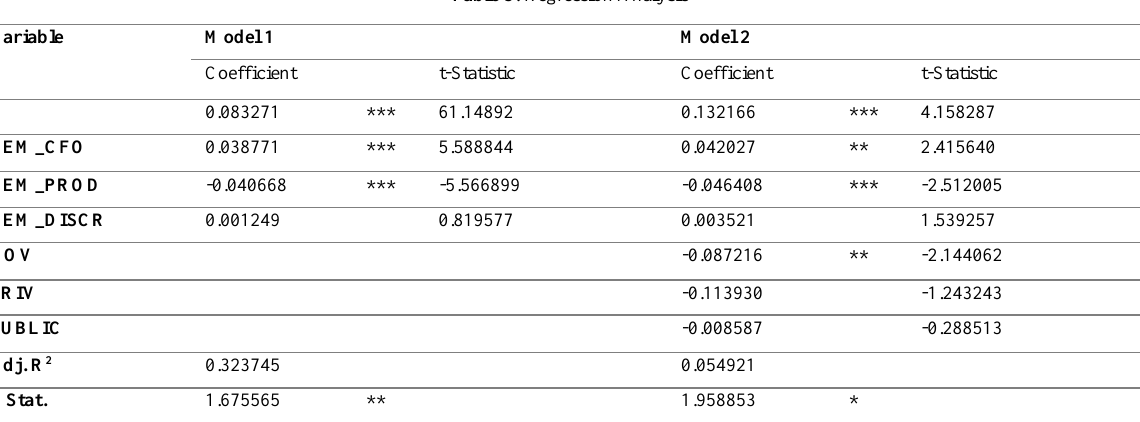
Table 3 : Regression